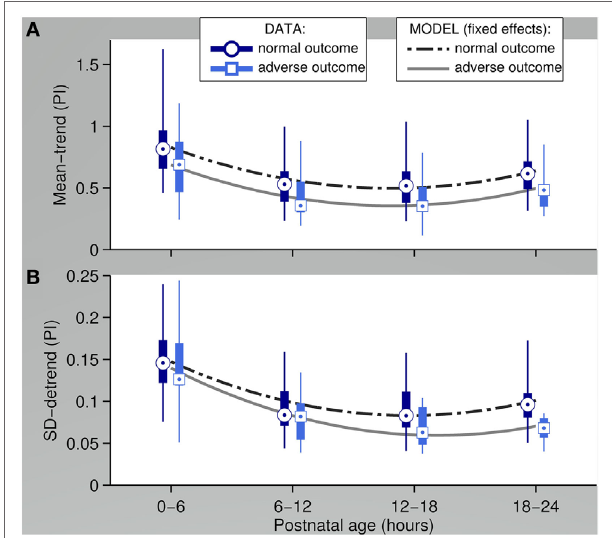
FiGURe 2 | Perfusion Index (PI) features assessed over a 6-h interval with fixed-effects (outcome group) from the mixed effects model in a study performed in extreme low gestational newborns. Adverse outcome was defined as early mortality or acquired brain injury (A) mean of the PI trend (B) SD of the PI detrend [data adapted from Van Laere et al.